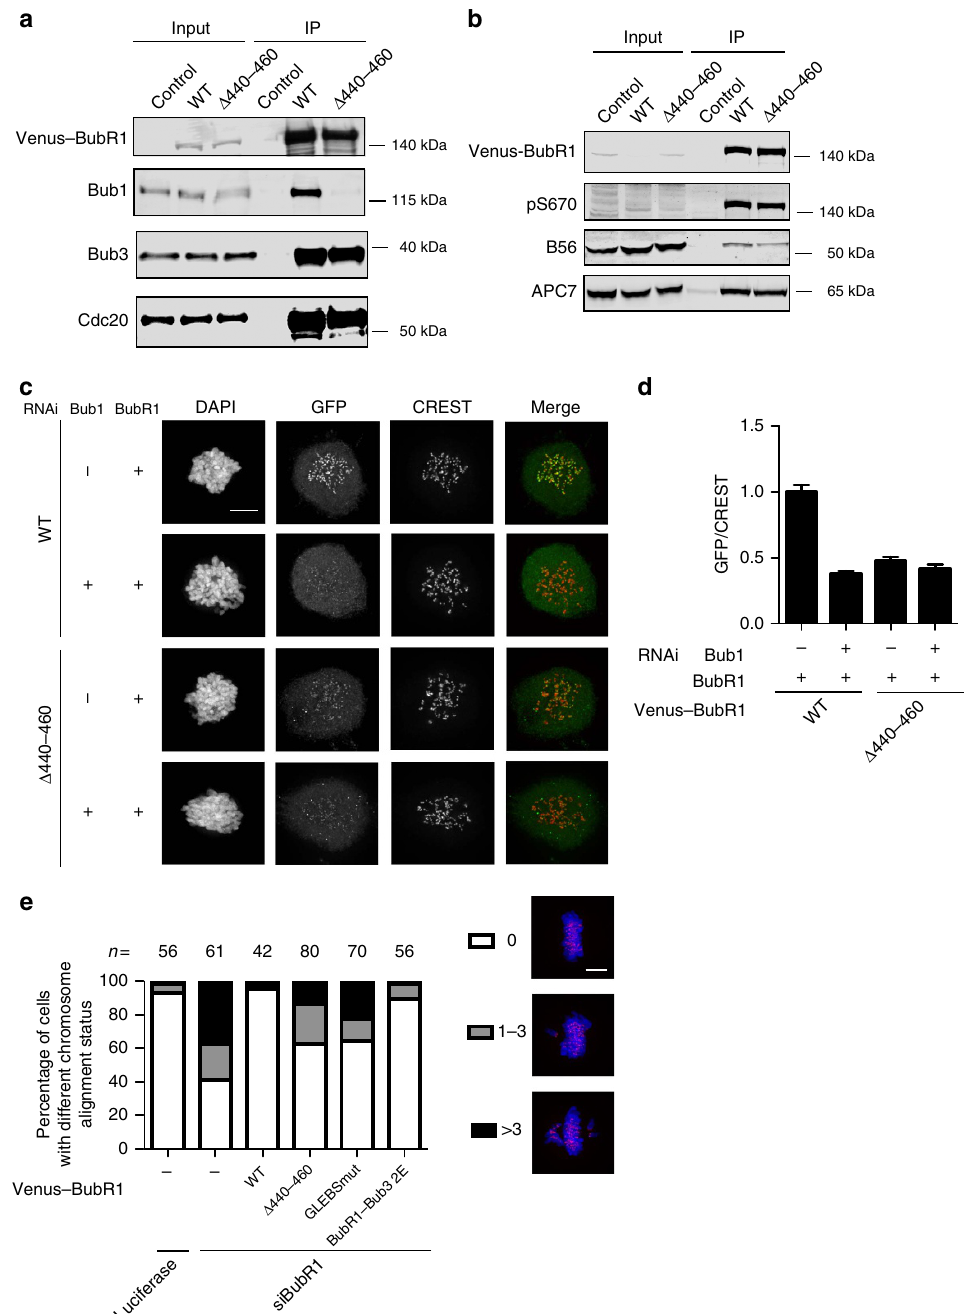
Figure 3 | Bub1-dependent BubR1/Bub3 localization supports chromosome alignment. ( a , b ) Venus–BubR1 or Venus–BubR1 D 440–460 plasmid was transfected into HeLa cells for 48h. After nocodazole treatment, mitotic cells were collected and lysed. Immunoprecipitation was performed against Venus tag by GFP-Trap beads. The presence of BubR1, Bub1, Bub3 and Cdc20 in a , and BubR1, BubR1 pS670, B56 and APC7 in b was analysed by Li-cor quantitative western blot. ( c ) RNAi-resistant Venus–BubR1 or Venus–BubR1 D 440–460 plasmid was co-transfected into HeLa cells with BubR1 RNAi oligo or both BubR1 and Bub1 RNAi oligos for 48h. After nocodazole treatment, cells were fixed and stained with 4,6-diamidino-2-phenylindole (DAPI), GFP and CRESTantibodies. Scale bar, 5 m m. ( d ) Kinetochore signals of BubR1 were determined and normalized to CREST. At least 160 individual kinetochores from eight cells were measured in each condition. The mean with s.e.m. is indicated. ( e ) HeLa cells were depleted of endogenous BubR1 and supplemented with RNAi-resistant Venus-tagged BubR1 WT, BubR1 D 440–460, BubR1 GLEBSmut or BubR1–Bub3 2E plasmid for 48h. Cells were arrested in metaphase for 1h by MG132 (10nM) before fixation. Unaligned chromosomes outside the metaphase plate were counted in each condition and plotted. n indicates the number of cells counted in each condition. Images on the right are representatives of chromosome alignment defects